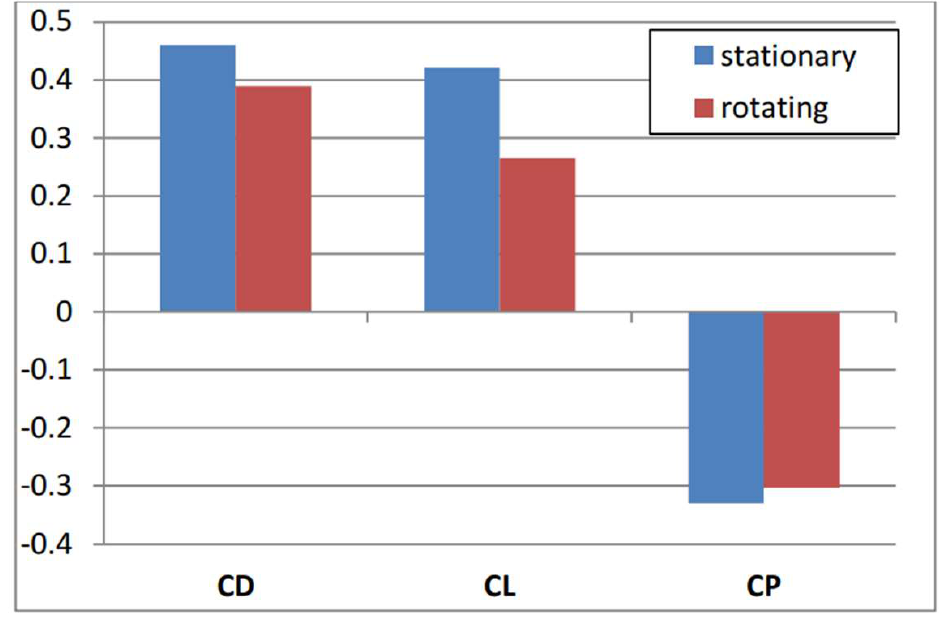
Figure 13. Performance comparison of the wheel with front wing -stationary and rotating wheel cases. The aerodynamic interaction of the wheel with the front wing can be quantified by the pressure coefficient distributions for the wing sections for the main airfoil and the flap. In Figure 14, the above distributions are compared for a wing section near the endplates (positioned at y = − 0.48 m) for the isolated front wing or with a stationary or rotating wheel installed. It is evident that the aerodynamic load of the isolated wing is higher than with the installed wheel. In fact, the negative peak near the lower leading edge of the main wing exceeds C p = − 3 but with the presence of the wheel, this peak is reduced by about a third, together with the depression on the suction side of the airfoils. This is because the wheel produces a flow blockage effect on the upstream wing that creates back pressure on the lower part (suction side) of the inverted wing by decreasing its velocity with a reduction of local depression. The effect of wheel rotation is modest on the above aerodynamic load. With a rotating wheel, a slightly deeper suction peak is observed. The different trends between the rotating and the stationary wheels are due to the flow energization given by rotation. The rotating wheel has a suction effect on the flow from the wing; the flow is dragged around the wheel with a beneficial effect on the suction peak, and it is possible to partially recover velocity and diminish the local pressure peak. The overall lift coefficient (downforce) of the isolated wing is C L = 1.25 and it drops to C L = 0.819 with a stationary wheel or C L = 0.957 with a rotating